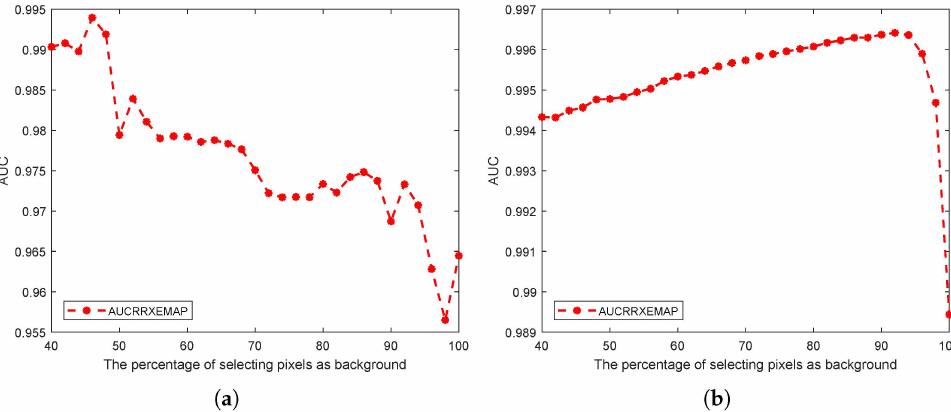
Figure 20. Effect of the percentage of pixels selected as background on each dataset. ( a ) AVIRIS-I. ( b )